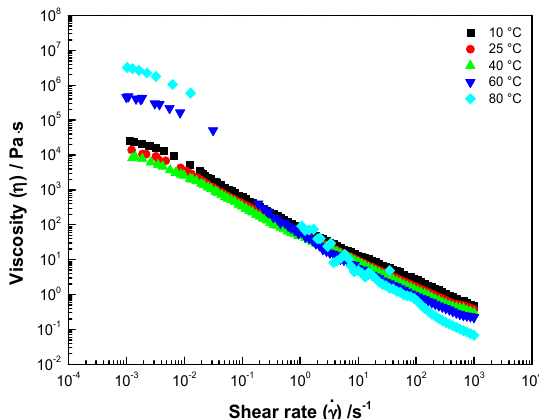
Figure 1. Viscous curves of hydrocolloids from Pereskia bleo leaves.